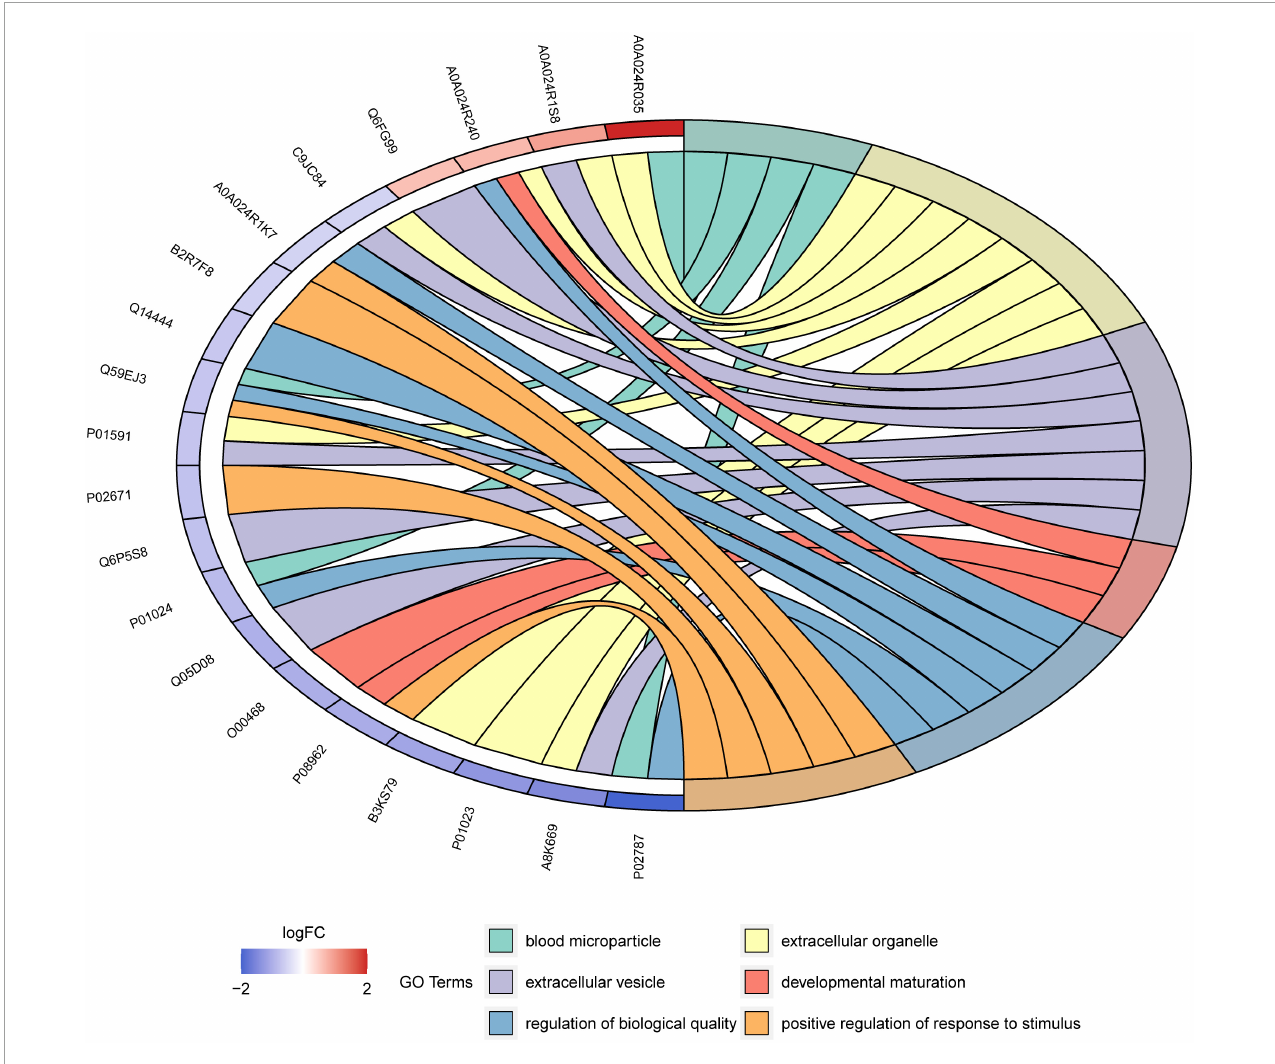
FIGURE7 Chord diagram for the first six enriched GO terms from Korean and Han ethnic groups in China.